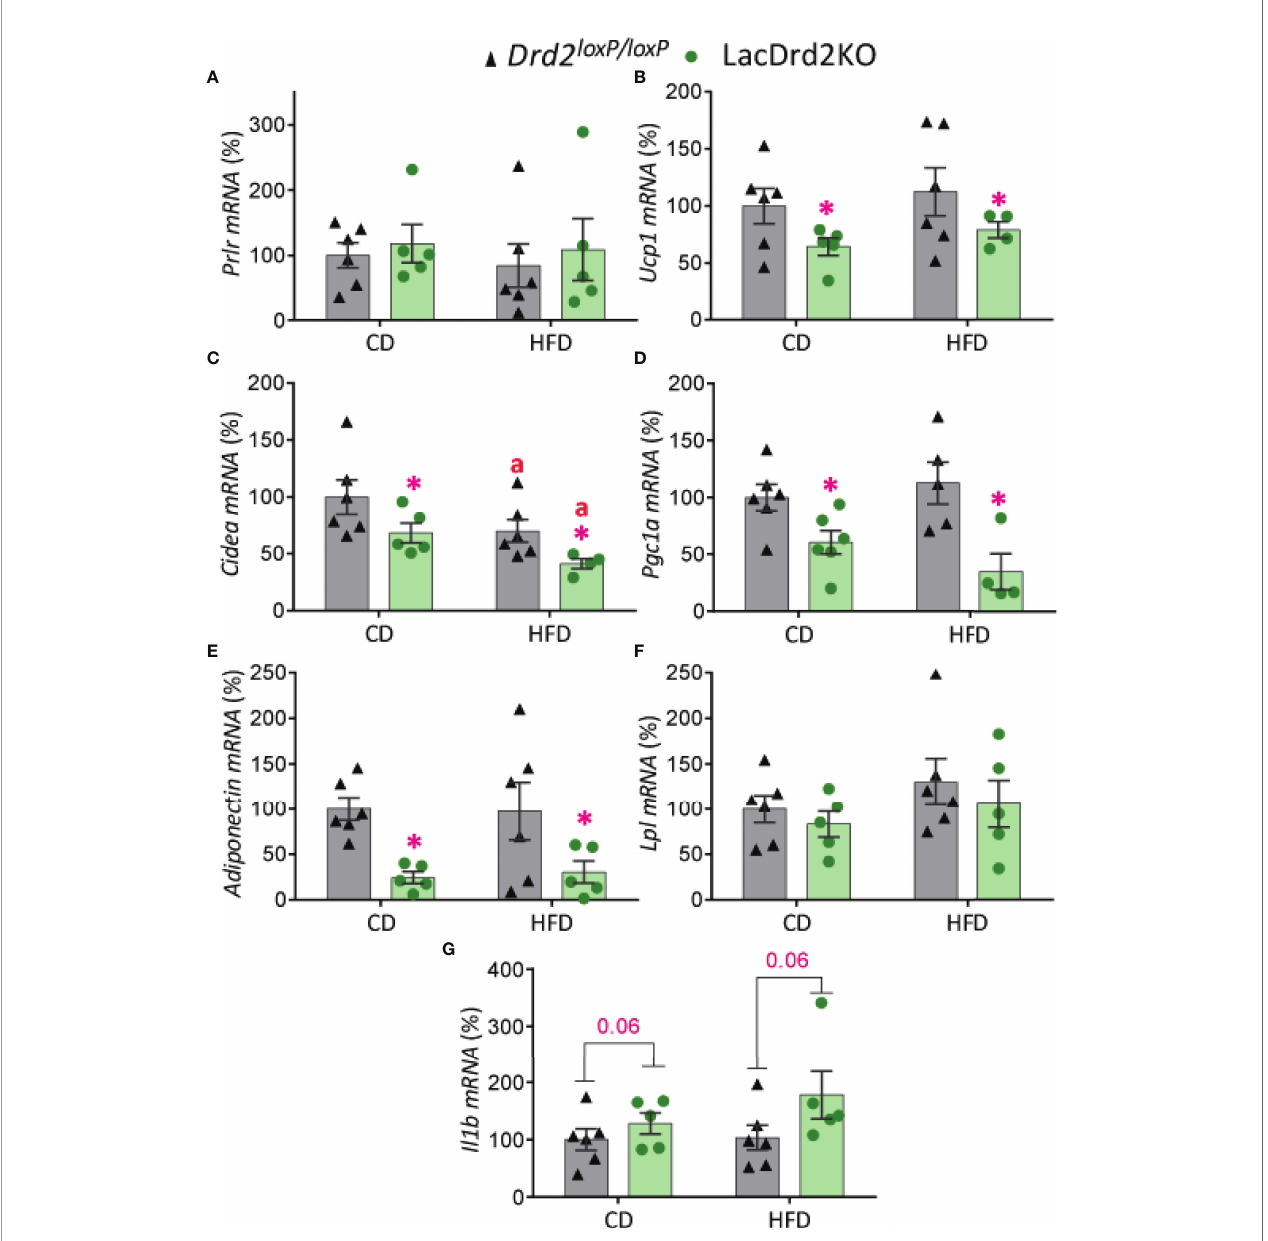
FIGURE 6 | Impact of hyperprolactinemia and high fat diet on gene expression pro fi le of brown adipose tissue. mRNA levels of (A) Prlr , (B-D) Ucp1 , Cidea and Pgc1a , indicators of thermogenic capacity (E) adiponectin, (F) Lpl , and (G) Il1b in Drd2 loxP/loxP and lacDrd2KO 5-month-old female mice with free access to a control diet (CD) or a HFD during two months. Drd2 loxP/loxP (CD, n = 6; HFD, n = 6), lacDrd2KO (CD, n = 5; HFD, n = 5). Two-way ANOVA; “ a ” P ≤ 0. 05 vs. genotype-matched mice fed with control diet, * P ≤ 0.05 vs. diet-matched Drd2 loxP/loxP